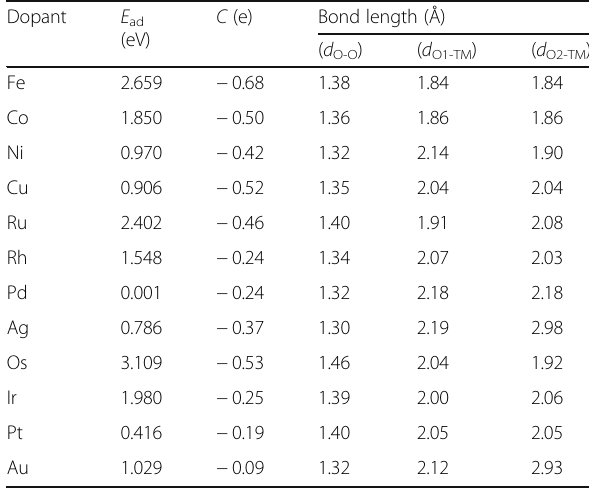
Table 2 Parameters of O 2 -(TM-phosphorene) adsorption systems: adsorption energy, charge transferred ( C ) from TM-phosphorene to the O 2 molecule, and calculated bond lengths of O – O and O –